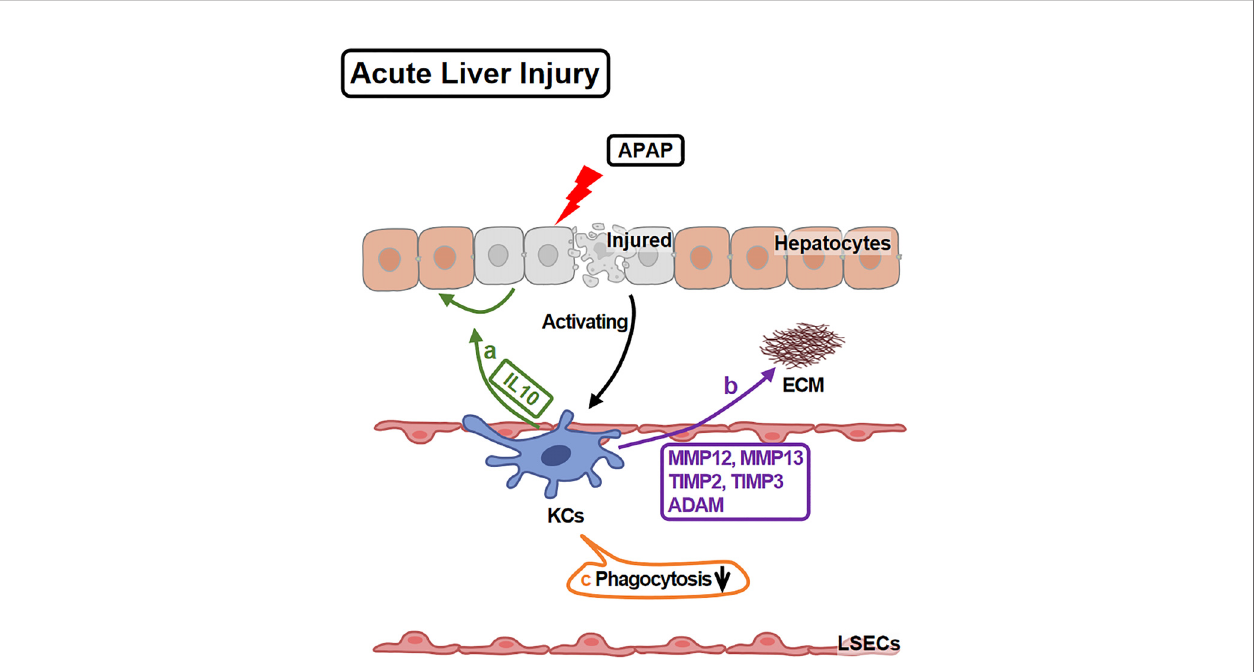
FIGURE 2 | KCs in APAP-induced Acute Liver Injury. APAP overdose leads to hepatocyte injury and death which activate KCs. Activated KCs initiate the repairing response: (A) KCs secrete IL10 to promote injured hepatocyte regeneration and survival. (B) KCs release MMP12, MMP13, TIMP2, TIMP3 and ADAM, remodeling ECM. (C) However, KCs phagocytotic ability is injured during these